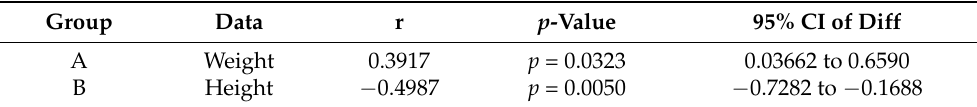
Table 5. Correlation (Pearson R coefficient test) between Epimysial fascia Ultrasound measurements and descriptive data within groups A and B. Only statistically significant data are